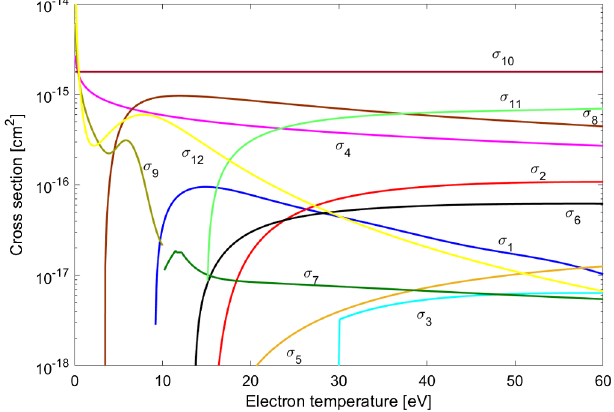
FIG. 5. Cross section of the 13 main reactions in a hydrogen plasma in the energy domain typical of MDIS [34].